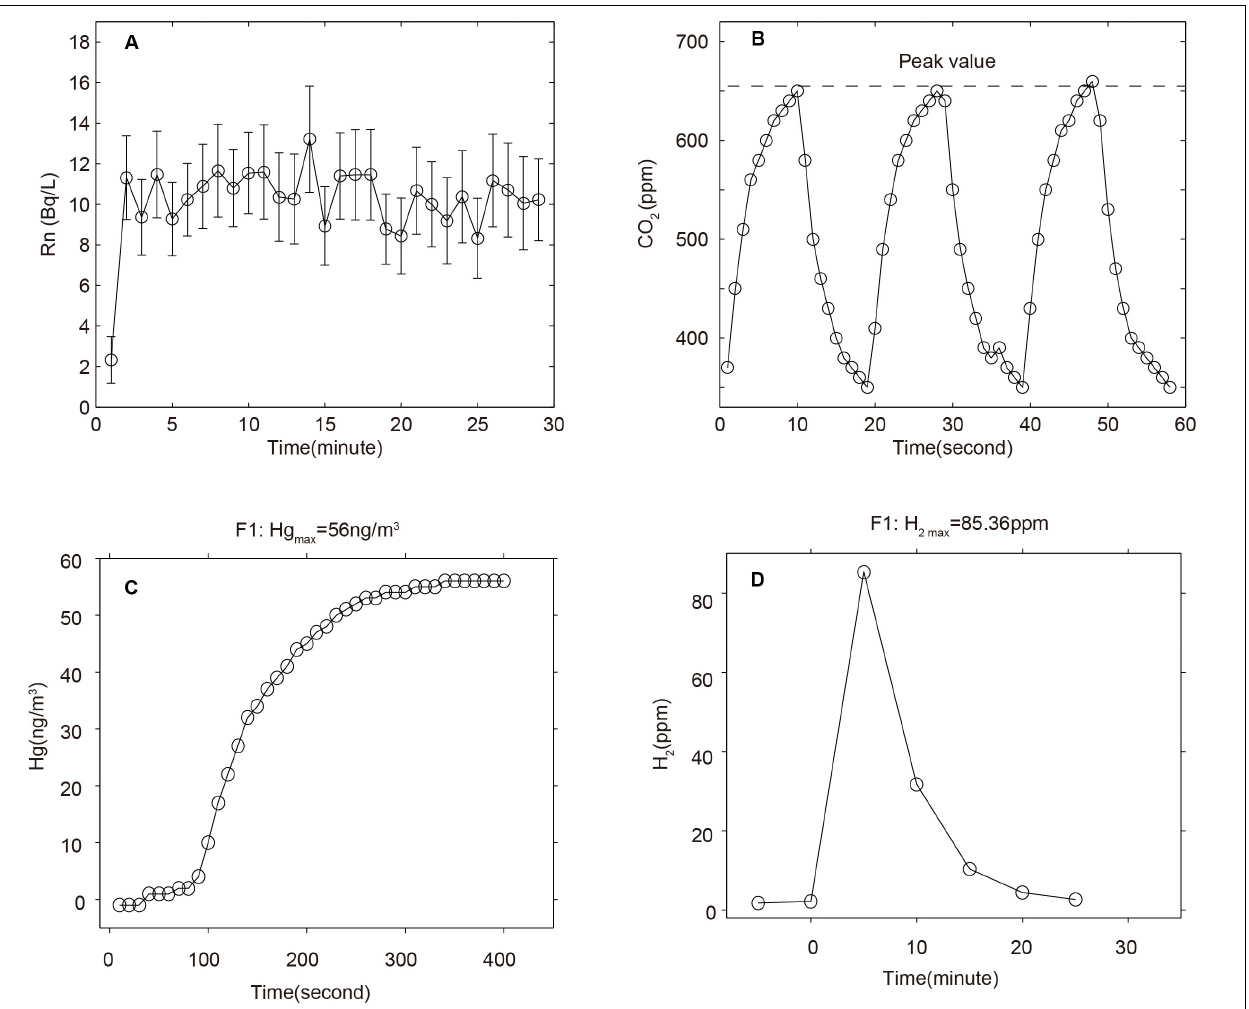
FIGURE 3 | The measurement curve of soil gas concentration in different components. The Rn concentration was determined according to the boxplot method to obtain the characteristics of Rn concentration at each site. A total of 30 measurements were acquired for each measurement point (A) . The other three components, soil gas concentration of CO 2 , Hg and H 2 were recorded based on the measurement time, respectively. The peak of CO 2 concentration was the same after repeated measurements (B) , The Hg concentration value showed a steady change after rising to the highest value (C) , H 2 concentration characteristics showed a rapid decrease after rising to the highest value (D) . Therefore, the maximum value of the gas concentration curve of each component at sampling sites is